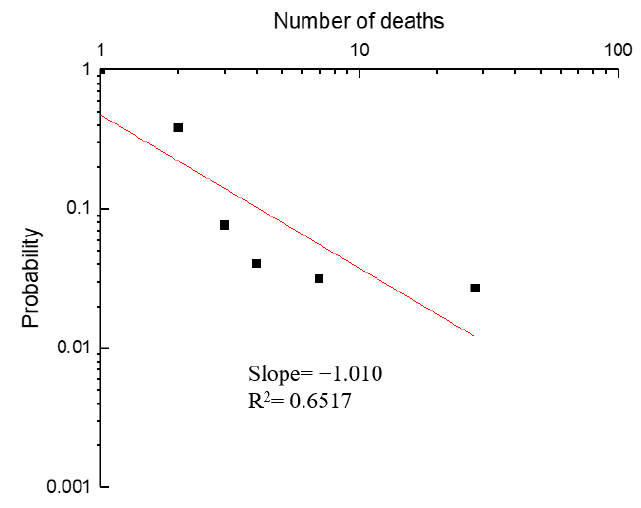
Figure 9. Accumulated probability of an accident with N deaths.